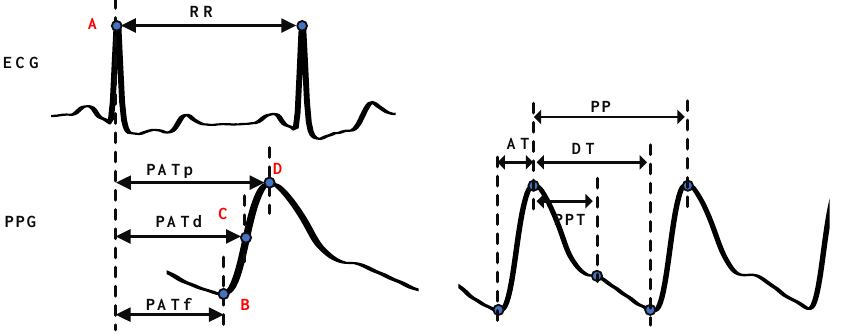
Figure 3. Schematic diagram of feature point detection.